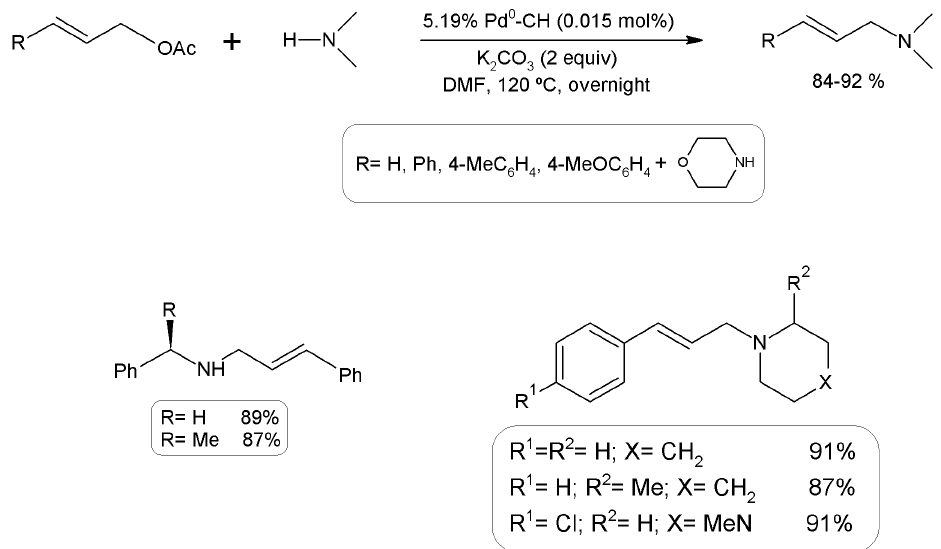
Figure 22. Coupling of allyl acetates with amines using chitosan-based catalysts loaded with Pd 0 .